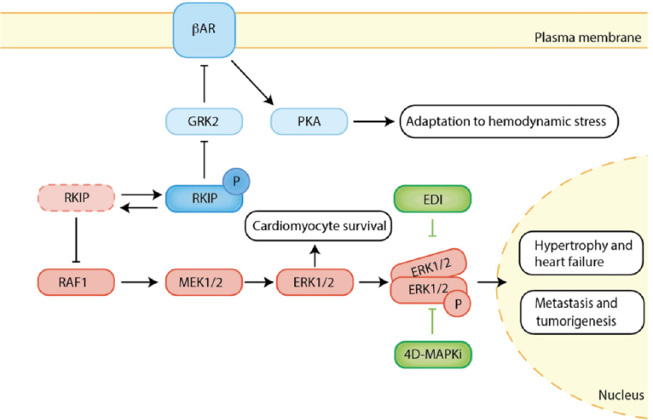
Figure 2. RKIP adapts to the respective cellular context and can thereby differentially affect Raf/MEK/ERK1/2 and β AR/PKA signaling depending on its phosphorylation status. RKIP results in the prevention of certain cancer types or a well-tolerated positive inotropy that can even protect from the development of heart failure in mice. The peptide EDI has potential to support the RKIP function in cancer and in heart disease by suppressing residual nuclear ERK1/2 signaling, and thus preventing cardiotoxicity, pathological cardiac hypertrophy, and heart failure, as well as supporting the inhibition of metastasis and tumorigenesis. Alternatively, the “4D MAPi”, a low dose multidrug strategy targeting MAPK signaling (ERK, JNK, p38), represents a strategy that mimics RKIP and has the potential, in particular in combination with EDI, to not only protect from cancer but also to attenuate cardiac hypertrophy and to be safe with regards to cardiotoxicity. Thus, the sophisticated targeting of the signaling cascades seems to pave the way to new multi-hit drug strategies.